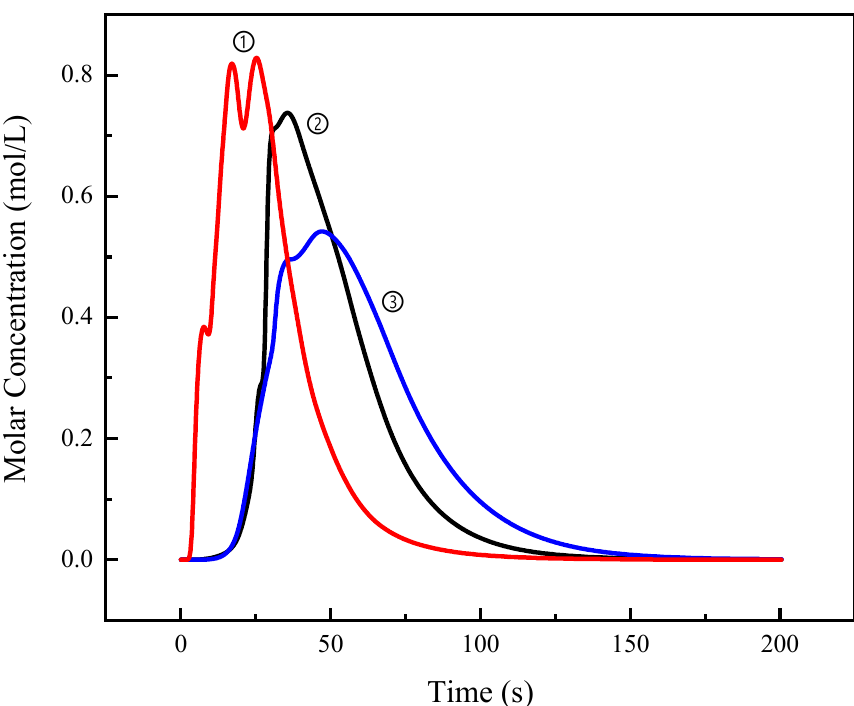
Figure 15. Concentration curve of each measurement point with time.